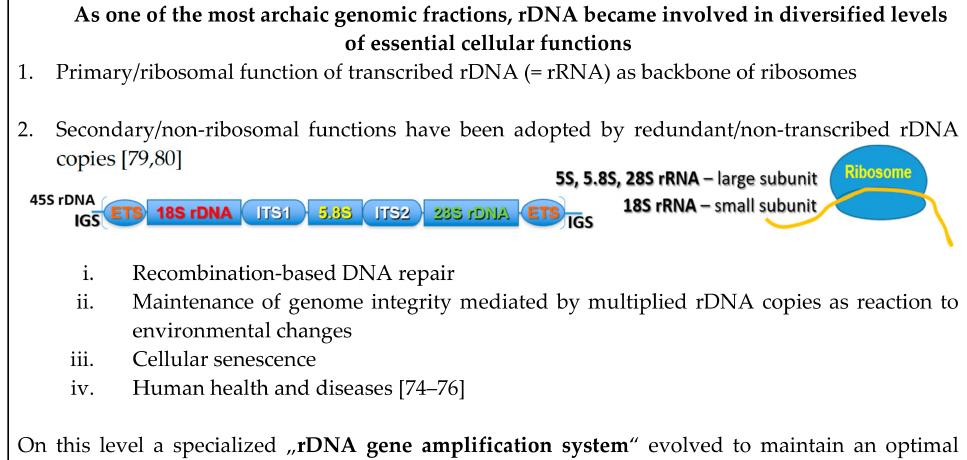
Figure 1. Three levels of ribosomal DNAs (rDNAs) functionality, generally and specifically in